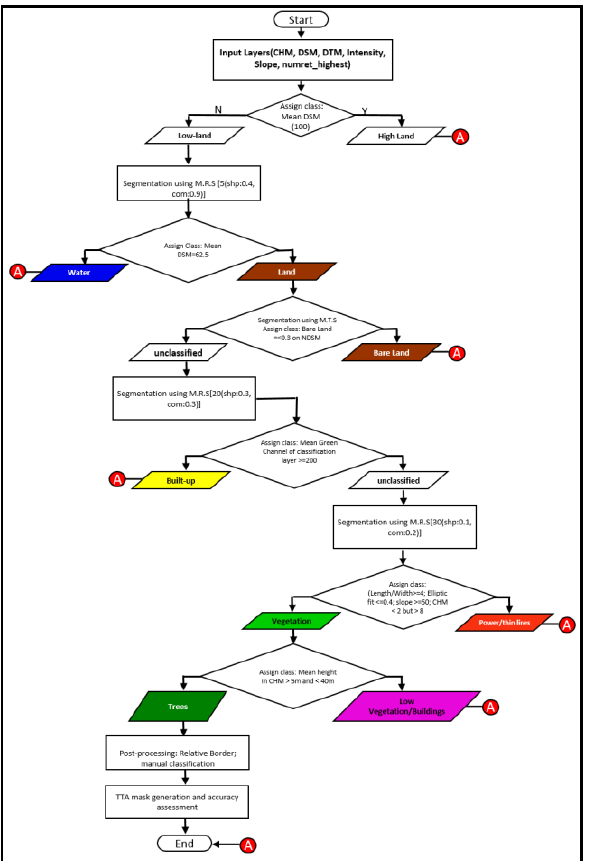
Figure 2. Workflow performed in eCognition software for tree extraction in Cebu City